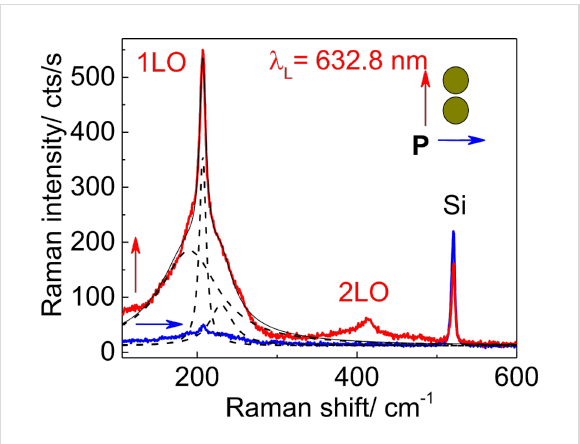
Figure 6: SERS spectra of a submonolayer of CdSe NCs deposited on the dimer array with a gap size of about 10 nm measured at λ L = 632.8 nm with parallel (vertical arrow) and perpendicular (hori- zontal arrow) polarized light with respect to the long dimer axis. The Lorentzian curves used for the fit of the Raman spectra as well as the fitting result are shown by dashed and solid lines, respectively.